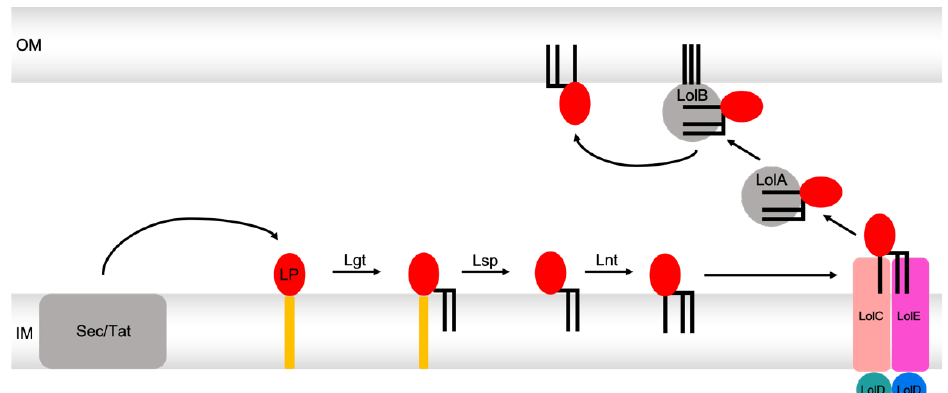
Figure 10. Overview of the Lol pathway. After insertion of lipoproteins (red, labeled one time with LP) via the Sec or the Tat pathway into the IM, they are diacylated (black) by Lgt in a first modification step. This is followed by cleavage of the N-terminal signal sequence (orange) by Lsp. Subsequently, Lnt acylates the newly N-terminally located cysteine, which makes the now mature lipoprotein ready for transport via the Lol machinery. This starts with the extraction of the lipoprotein from the cytoplasmic membrane via the ABC transporter LolCDE (salmon, light magenta, deep teal, and marine), which leads to the delivery of the lipoprotein to the periplasmic chaperone LolA (grey). LolA shuffles the lipoprotein to the last checkpoint LolB (grey), which finally inserts the lipoprotein into the outer membrane.